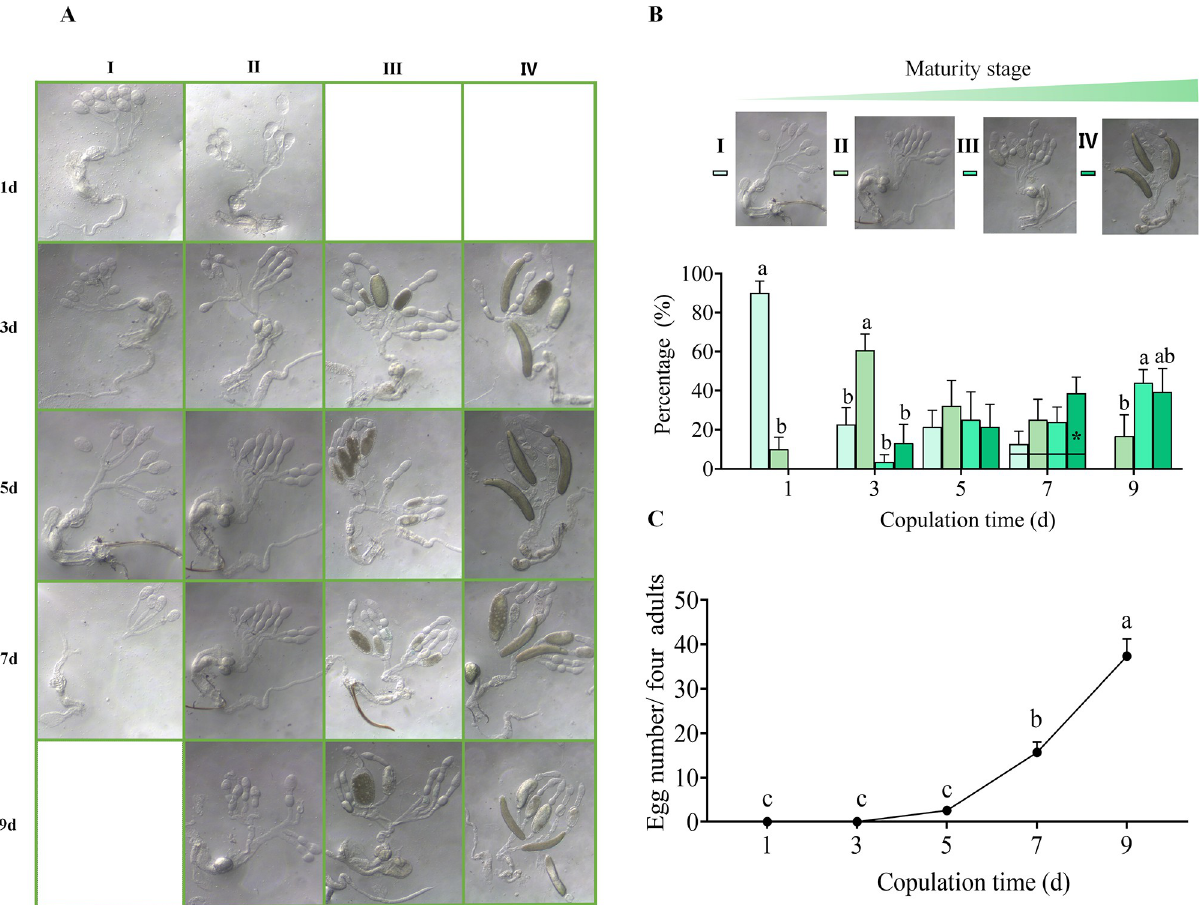
Fig 3. Morphological changes of the inner reproductive system (A), proportion of each maturity stage in different copulation time (B), and egg amounts deposited in the corresponding treatment (C). Stage I-IV referred to the ovary maturity stage I-IV. 1d, 3d, 5d, 7d, and 9d referred to the continuous copulation time. Data are from mean (+SE). For each time point, different letters indicate significant differences among treatments ( P < 0.05, Tukey’s honest significant difference (HSD) post-hoc test, n = 19–28).